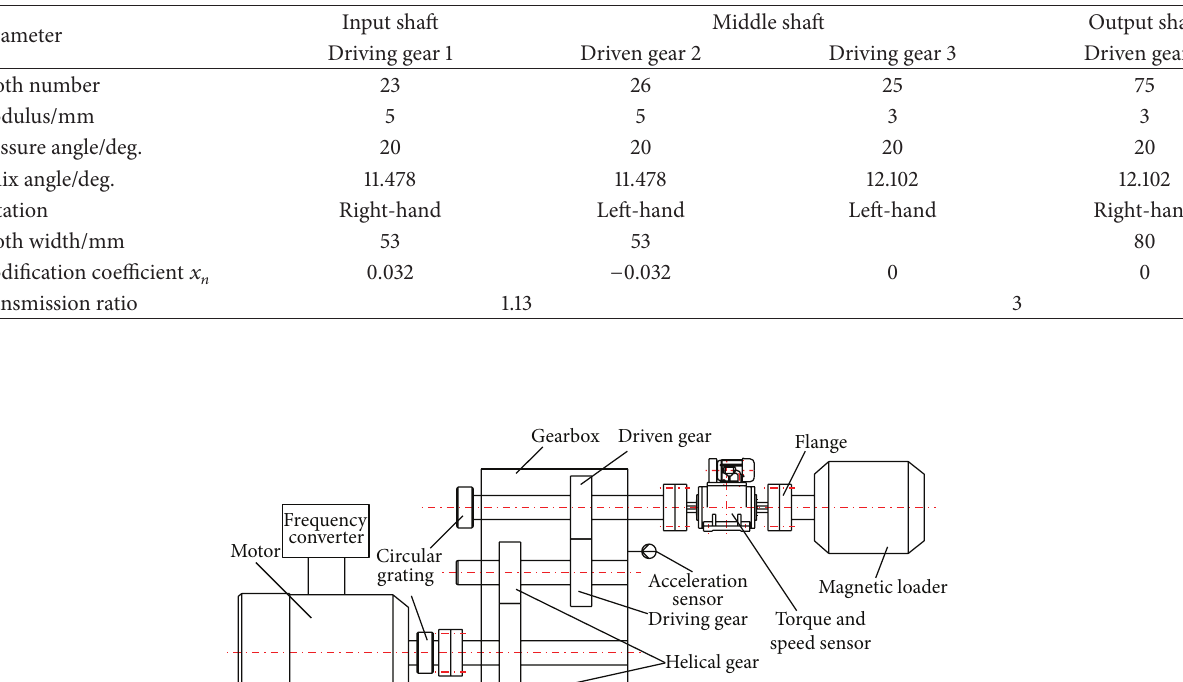
Table 1: Parameters of the gearbox.